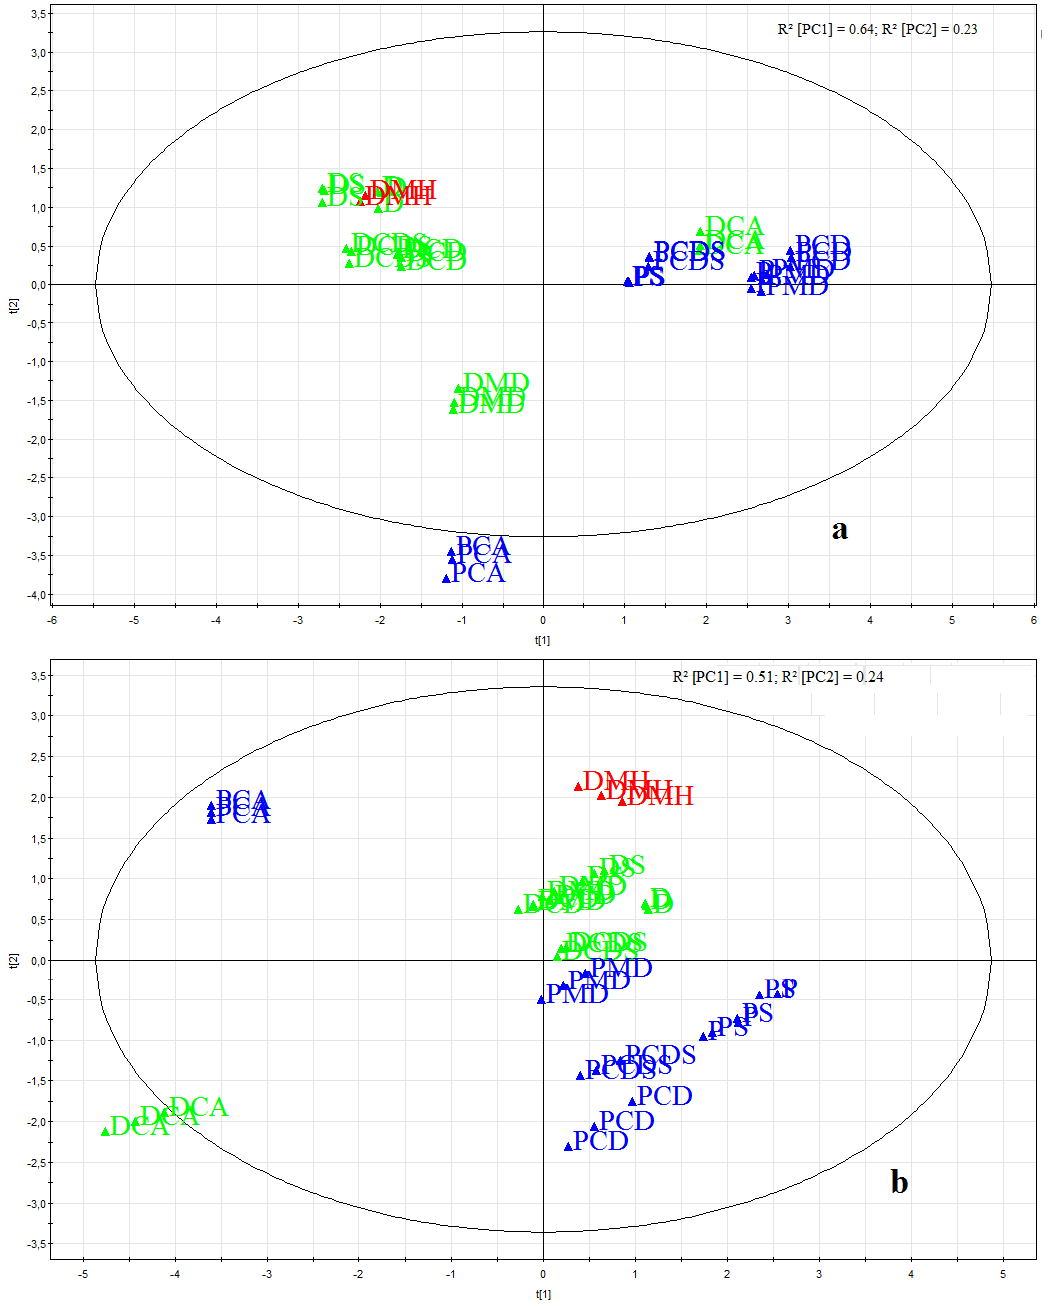
Figure 6. Principal component analysis: score scatter plots ( a ) Insent system; all seven sensors included; ( b ) α Astree system; all seven sensors included; ( c ) Insent and α Astree systems; all 14 sensors included. pure drug substance (red); drug-loaded formulations (green); drug-free formulations